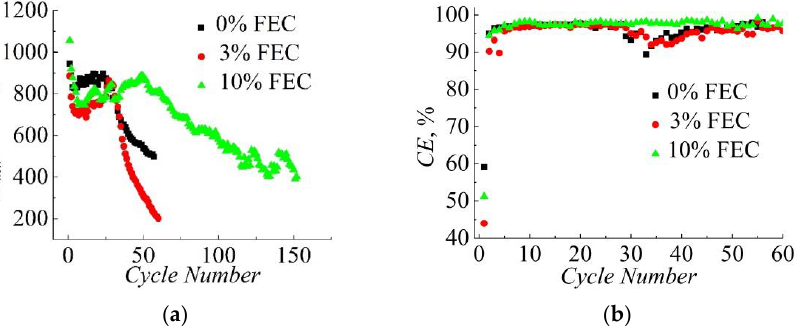
Figure 1. Dependence of the discharge capacity ( a ) and Columbic efficiency ( b ) on the cycle number for composite anodes in the form of pellets. The current density during the first lithiation was 25 mA/g, during the first delithiation, and in subsequent cycles 50 mA/g.